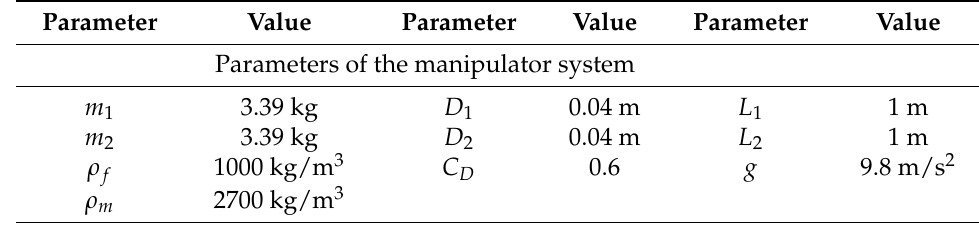
Table 1. Parameters of the manipulator system and the model simulation. Sliding mode (SM); adap- tive super twisting algorithm (ASTA); higher–order super–twisting disturbance observer